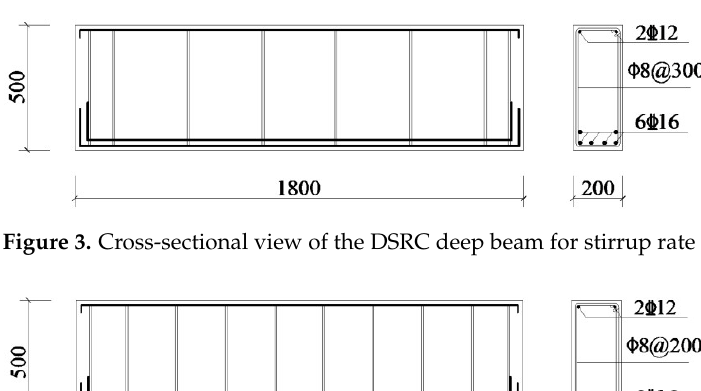
Figure 2. Cross-sectional view of the DSRC deep beam for stirrup rate ρ v = 0%.